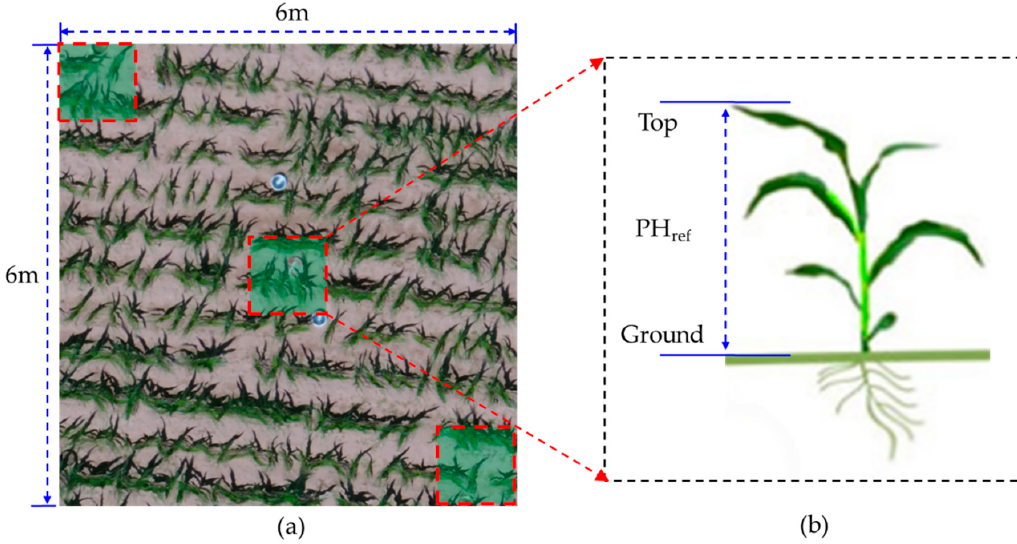
Figure 2. The locations of sampling site within each sampling plot ( a ) and the measuring method of maize plant height within each sampling site ( b ). PH ref represents the reference plant height.